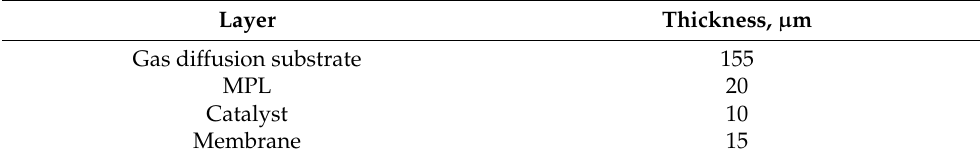
Table 2. Thickness of MEA